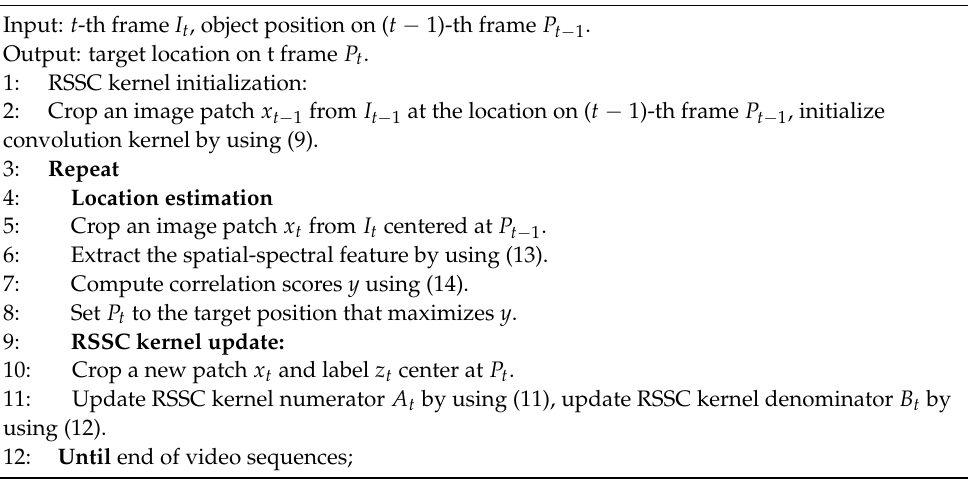
Algorithm 1: FSSF-Based Hyperspectral Video Tracking